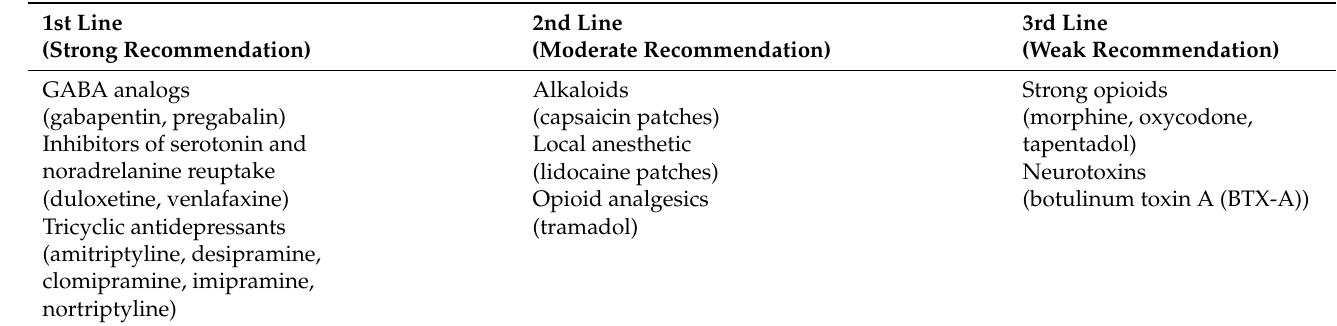
Table 1. Proposed pharmacological treatments for neuropathies based on GRADE (Grading of Recommendations, Assessment, Development, and Evaluation)